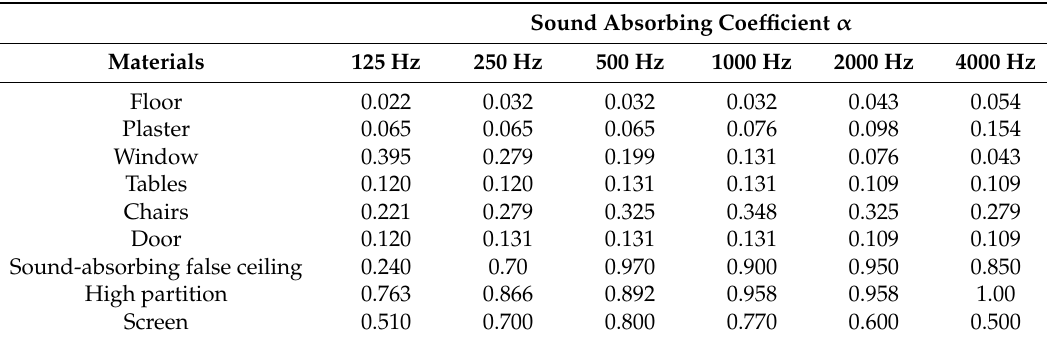
Table 5. Sound absorption coefficient of the materials used for the